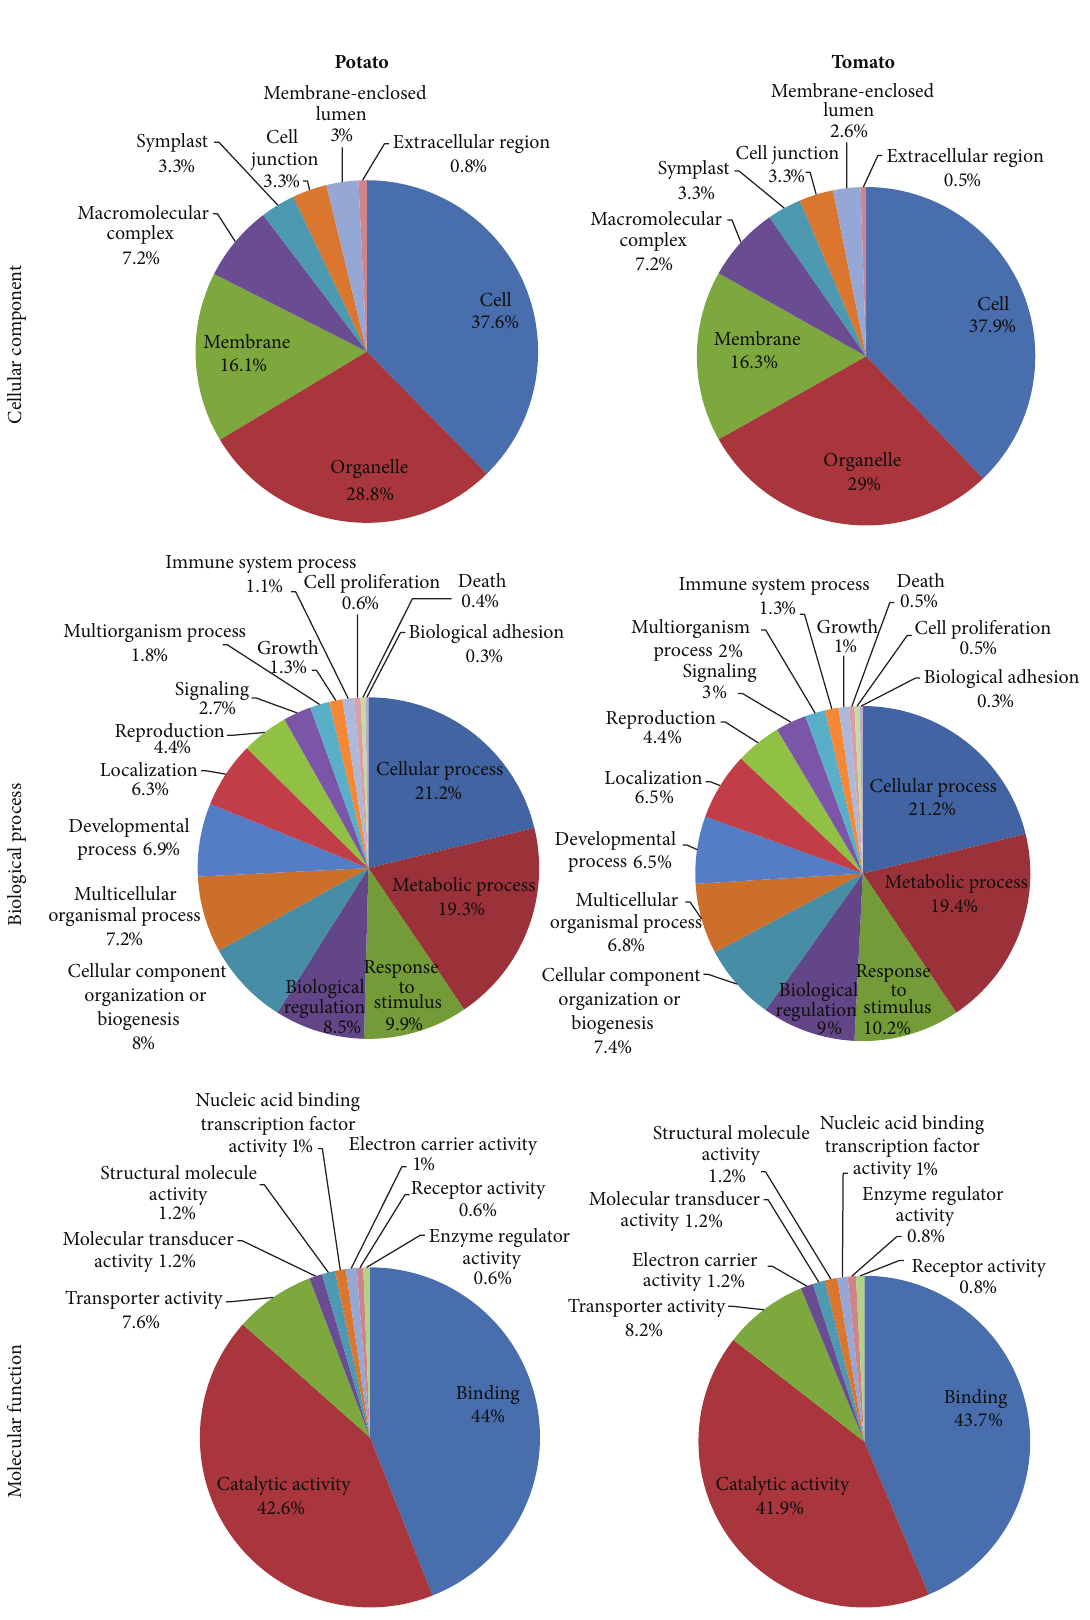
Figure 3: BLAST2GO analyses of the genes overlapping DArT marker